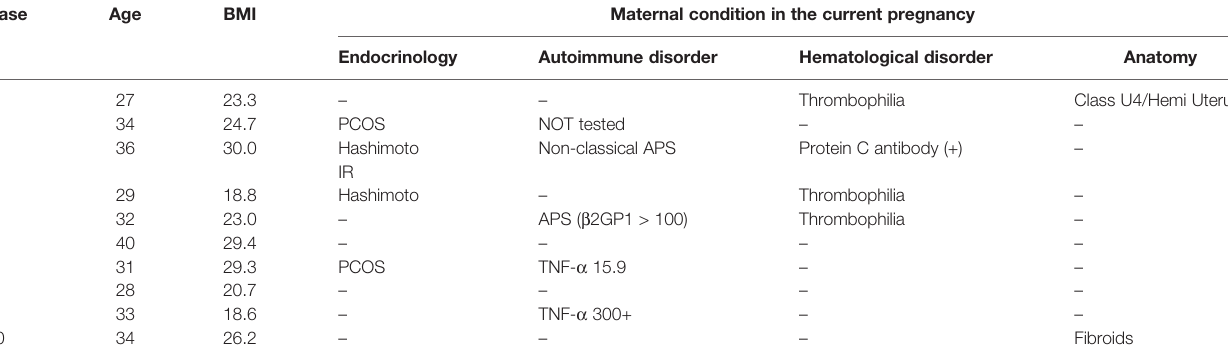
TABLE 1 | Demographic data and main disorders complicating pregnancy in the case